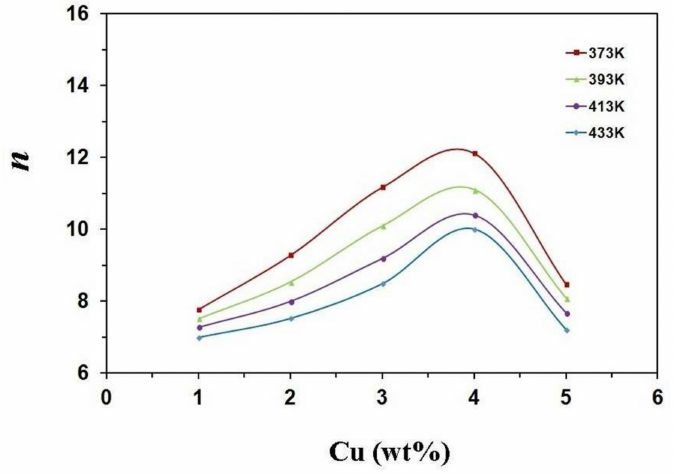
Figure 24. Plot between stress component (n) and wt% of Cu